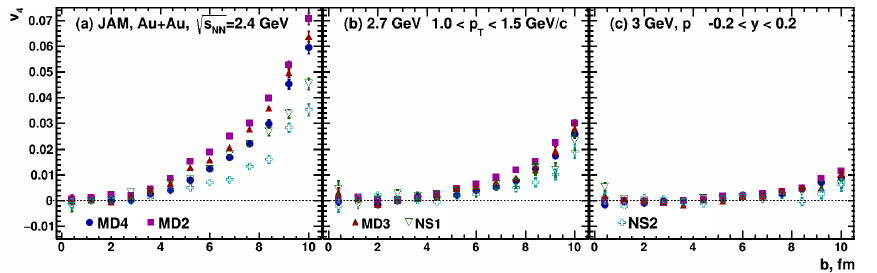
Figure 22. Impact parameter dependence of quadrangular flow v 4 of protons in the transverse momentum interval 1.0 < p T < 1.5 GeV/c at mid-rapidity | y cm | < 0.2 from Au + Au collisions at beam √ s NN = 2.4 GeV (panel ( a )), 2.7 GeV (panel ( b )), and 3.0 GeV (panel ( c )). Different symbols energies correspond to the different EOS implementations in the JAM model: soft momentum independent NS2 ( K 0 = 210 MeV), hard momentum independent NS1 ( K 0 = 380 MeV), soft momentum dependent MD4 ( K 0 = 210 MeV) and hard momentum dependent MD2 and MD3 ( K 0 = 380 MeV).